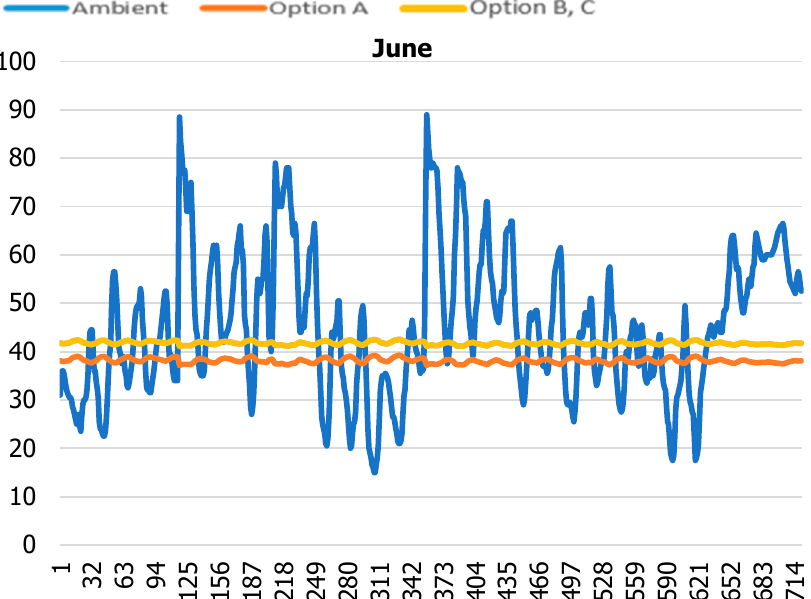
Figure 28. RH Comparison for the month of June. Note: option B and option C had the same relative humidity, with a value of 40.5%. The results for option B and option C are merged and displayed a single yellow line.